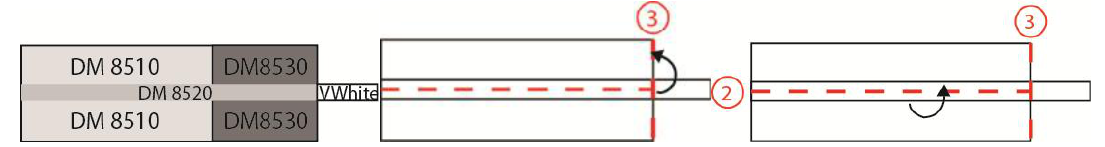
Figure 35. Materials and folding lines 2 and 3.